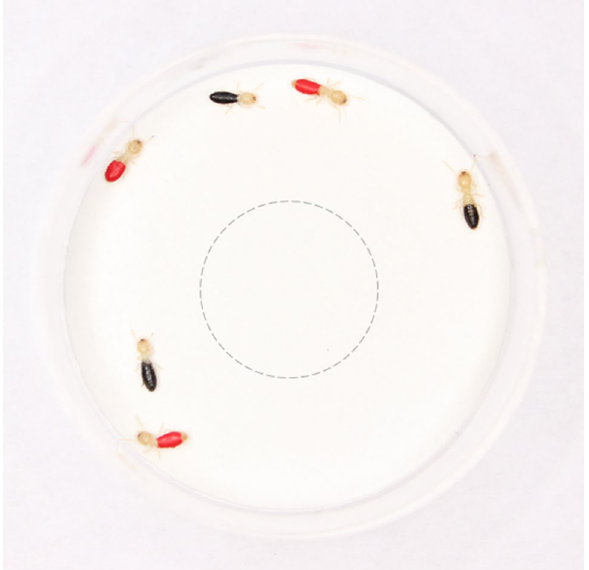
Figure 1. Testing arena with painted termites used in color preference tests. The arena was a round 9 cm diameter plastic petri dish lined with white filter paper. In the center of the arena, we placed a clear 3.5 cm diameter acclimation chamber (indicated by the dotted line). We released spiders from this acclimation chamber during choice tests to allow them to forage on the surrounding